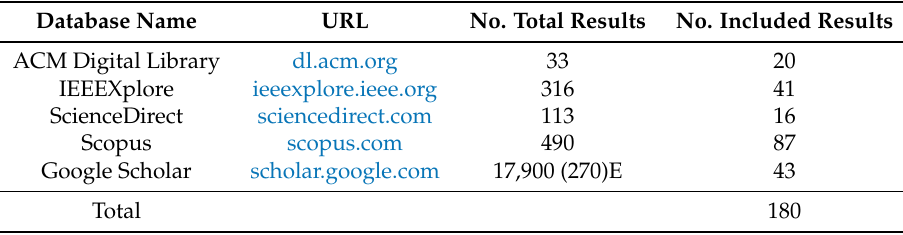
Table 1. Databases with search results and total after removed duplicates.